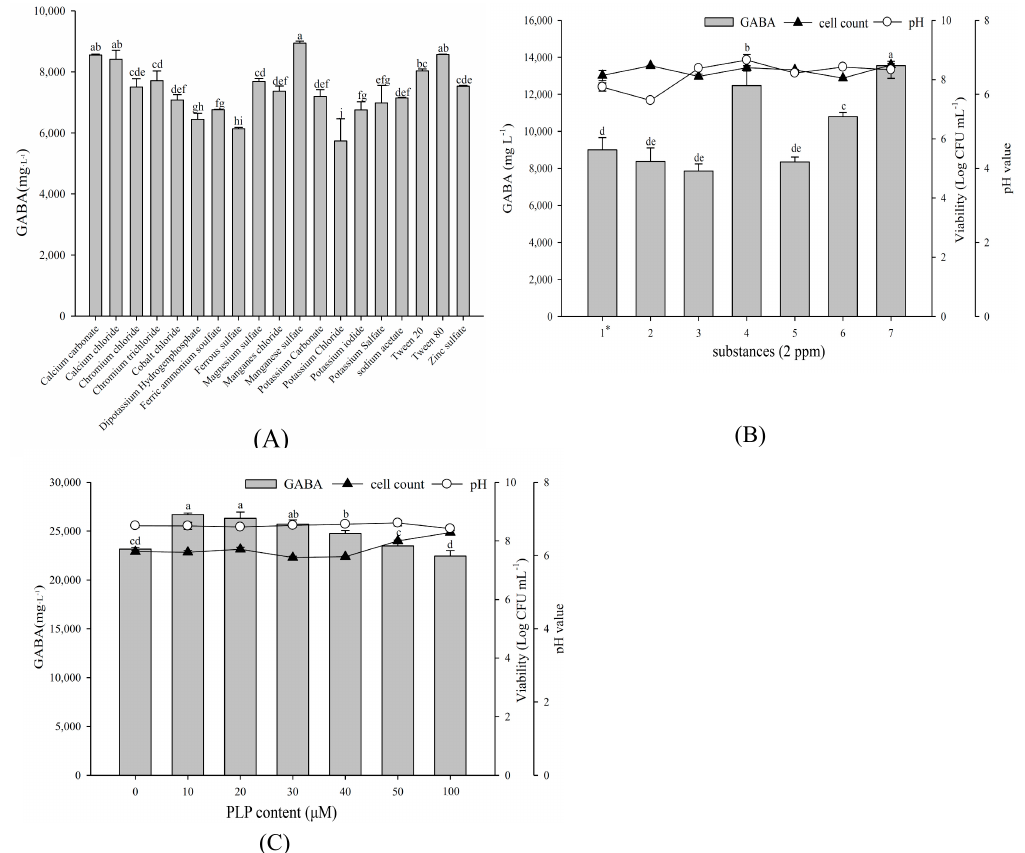
Figure 3. The effects of various substances on GABA production, cell viability and final pH values. ( A ) Bacterial cells were grown at 1% MSG, 1% glucose, and 2.5% yeast extract, and different substances at 2 ppm. Bacterial cells were cultivated with: ( B ) selected substances for 96 h at 30 ◦ C; and ( C ) at different PLP contents for 96 h at 30 ◦ C. 1 *: calcium carbonate; 2: manganese sulfate; 3: Tween 80; 4: calcium carbonate and manganese sulfate; 5: calcium carbonate and Tween 80; 6: manganese sulfate and Tween 80; 7: calcium carbonate, manganese sulfate, and Tween 80. Data are expressed